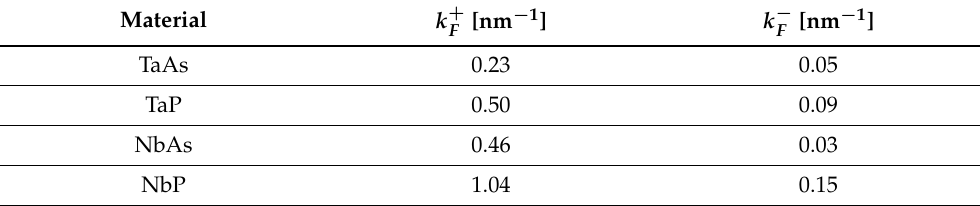
Table 1. Values of k ξ